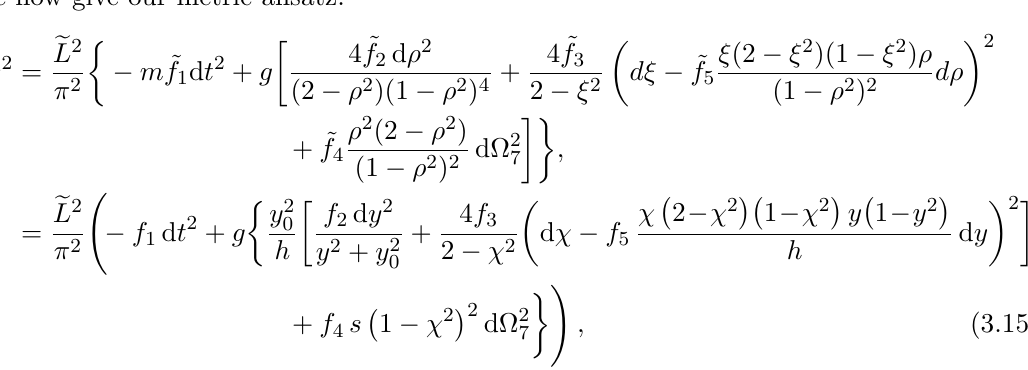
p 2 (cid:0) (cid:26) 2 = (1 (cid:0) (cid:26) 2 ) and e (cid:18) = 2 arcsin( (cid:24)=